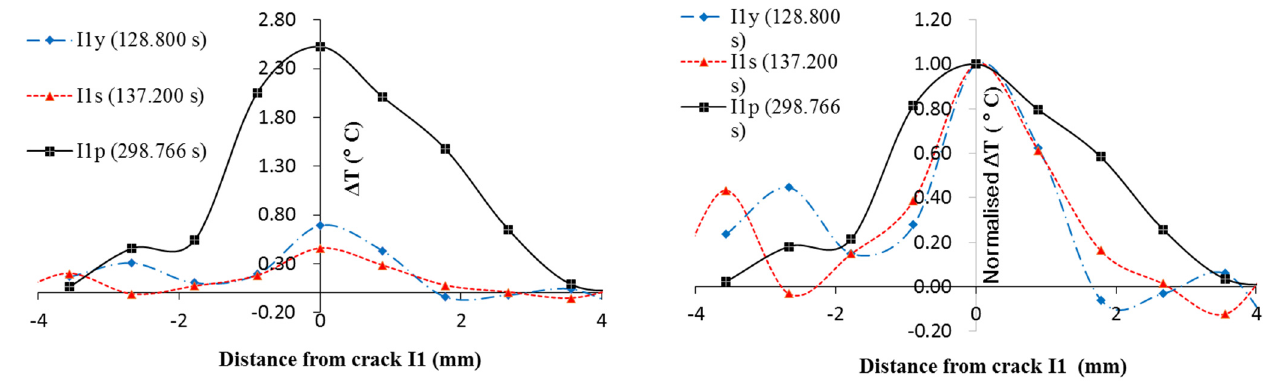
Figure 17. Temperature profile and normalized Δ𝑇 at crack I1 at yield, stress softening, and plastic stage.